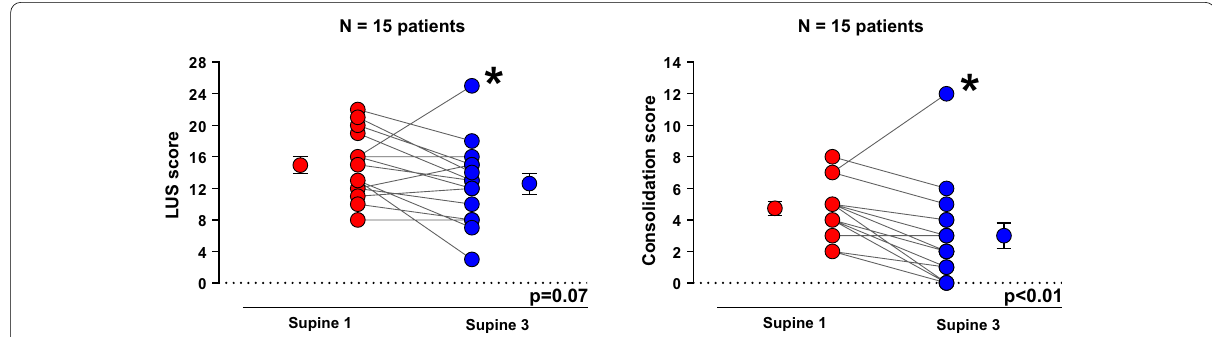
Fig. 3 Evaluation of aeration by lung ultrasound between supine‑1 (baseline) and supine‑3 (after second lateral positioning). The analysis of the individual data shows an improvement in LUS score (left figure) and consolidation score (right figure) in the majority of patients. A non‑responder patient is identified with asterisk *LUS score: lung ultrasound score. Paired t test was used for the analysis of LUS score and Wilcoxon signed‑rank test for the consolidation